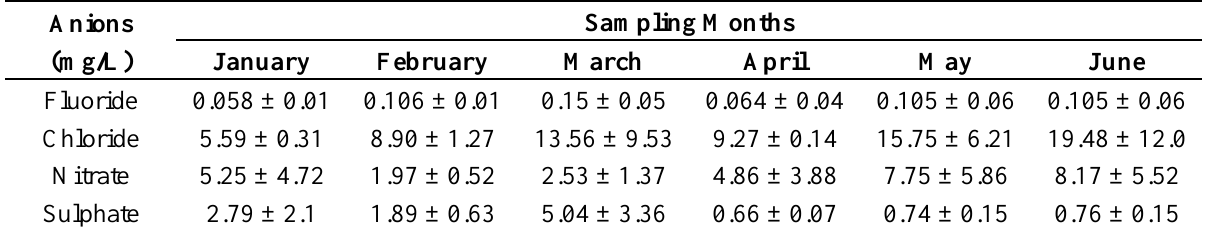
Table 2. Average monthly concentrations of anions in Mvudi